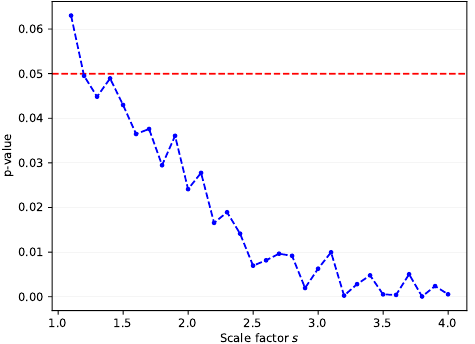
Figure 5. p -value over all scale factors on MPII dataset. This result demonstrates that the improved performance of the proposed method with respect to the baseline is significant at α = 0.05.